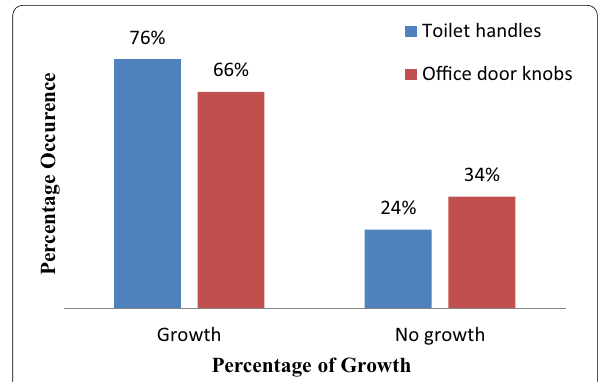
Fig. 1 Sample-based variation in growth frequency on bile esculin